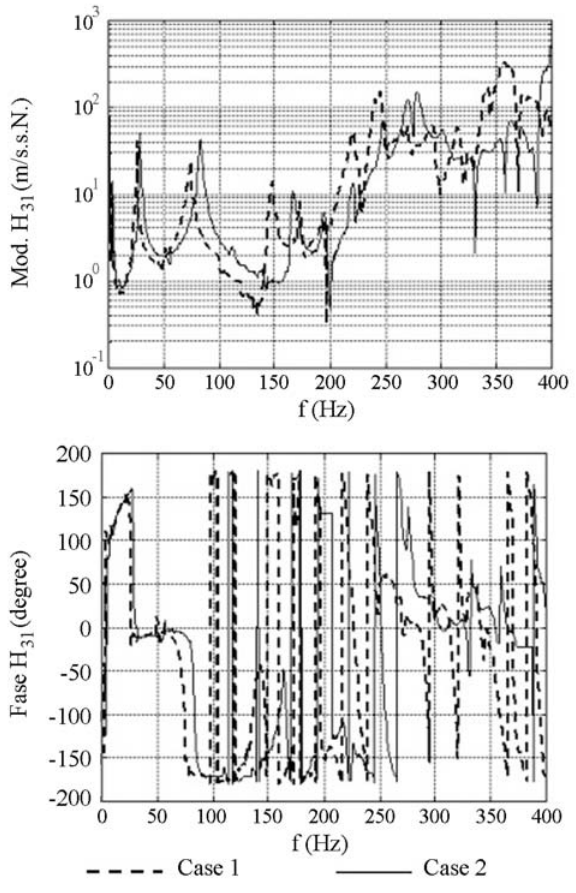
Figure 6. Frequency Response Function (FRF) corresponding to H 31